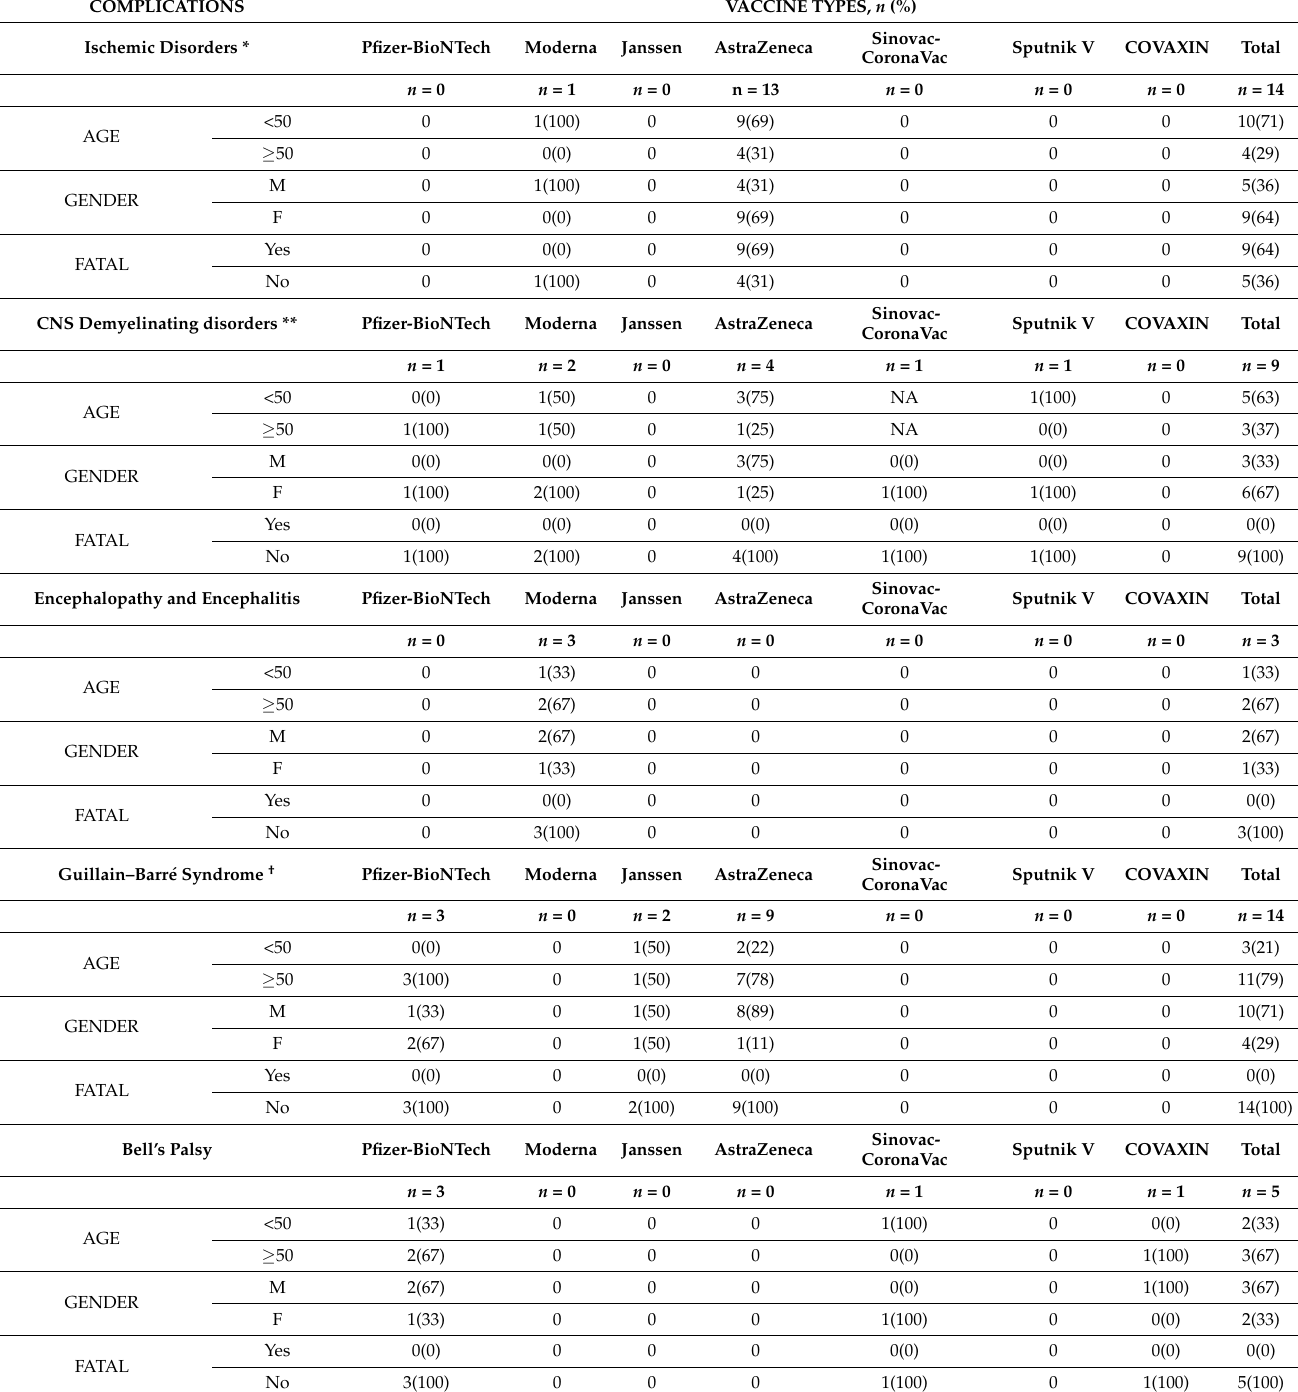
Table 3. Comparison of neurological manifestations ( n = 51) against age, outcomes, and types of COVID-19